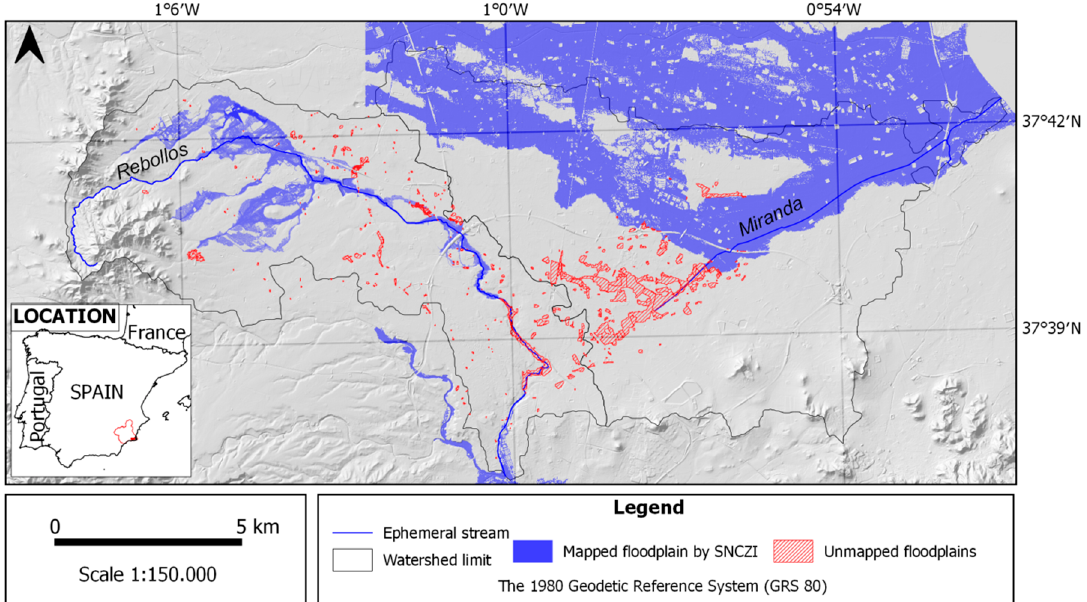
Figure 16. Floodable areas that have not been mapped by the official SNCZI mapping.